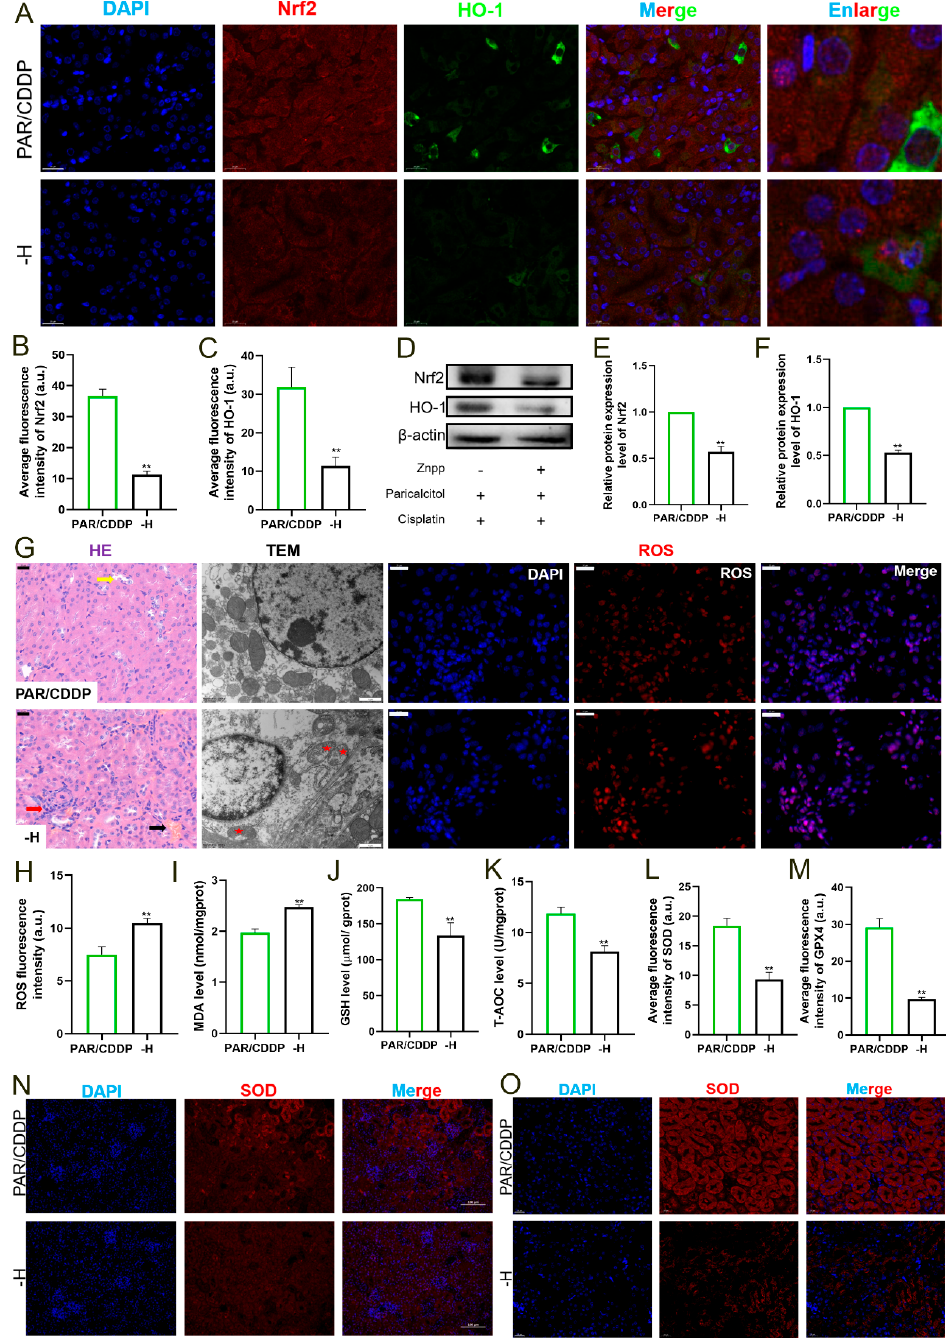
Figure 6. Inhibiting HO-1 expression reduces the anti-oxidation levels of paricalcitol. ( A – C ) Repre- sentative images and quantification for immunofluorescence of Nrf2 (red) and HO-1 (green) (scale bars, 20 μ m; n = 3). ( D – F ) The protein expressions of Nrf2 and HO-1 in mice kidneys ( n = 3). ( G ) Representative images of HE (scale bars, 20 μ m), TEM (scale bars, 1 μ m) and ROS (scale bars, 20 μ m) in mice renal tissues ( n = 3). ( H ) ROS quantification. ( I – K ) The levels of MDA, GSH and T-AOC in mice kidneys ( n = 6). ( L – O ) Representative images and quantification for immunofluorescence of SOD and GPX4 (scale bars, 20 μ m; n = 3). PAR/CDDP, paricalcitol + cisplatin group; -H, ZnPP+ paricalcitol + cisplatin group. ** p < 0.01. Dates are presented as Mean ± SD. Statistical significance was obtained by unpaired Student’s t